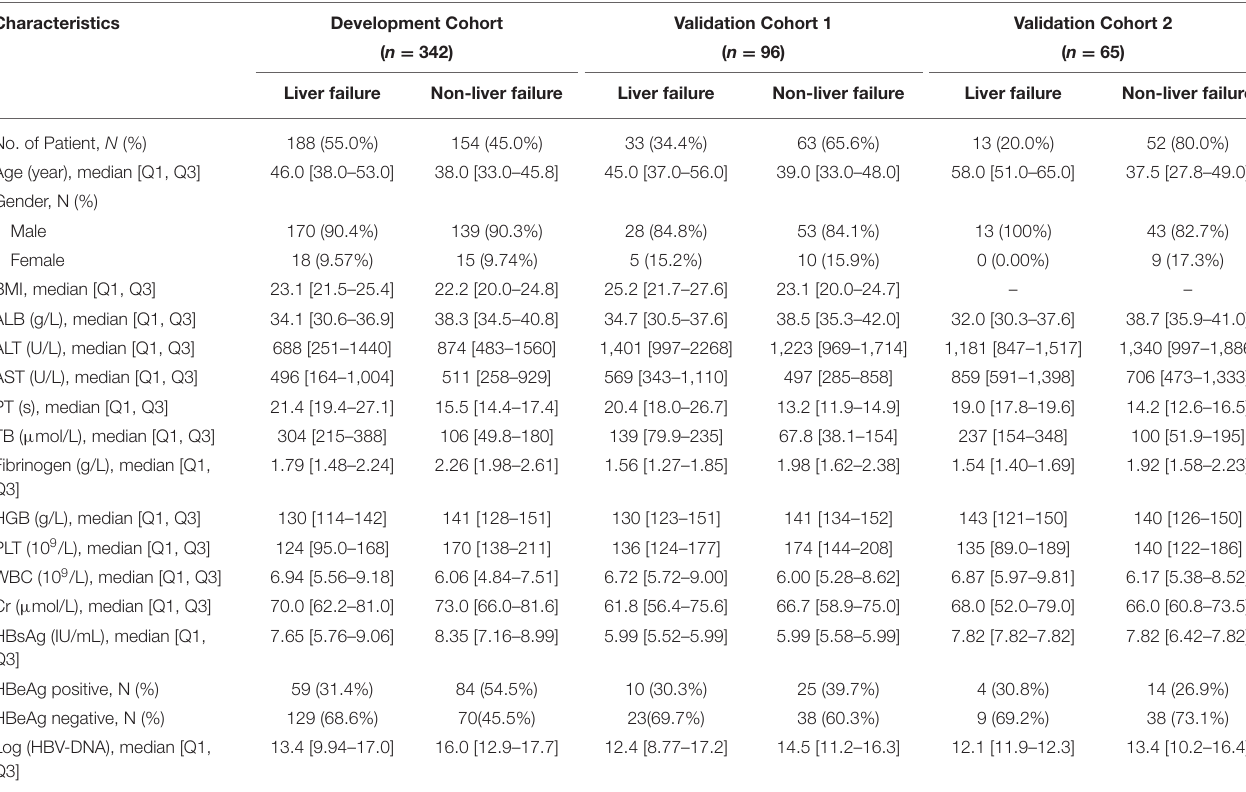
TABLE 1 | Clinical characteristics of study